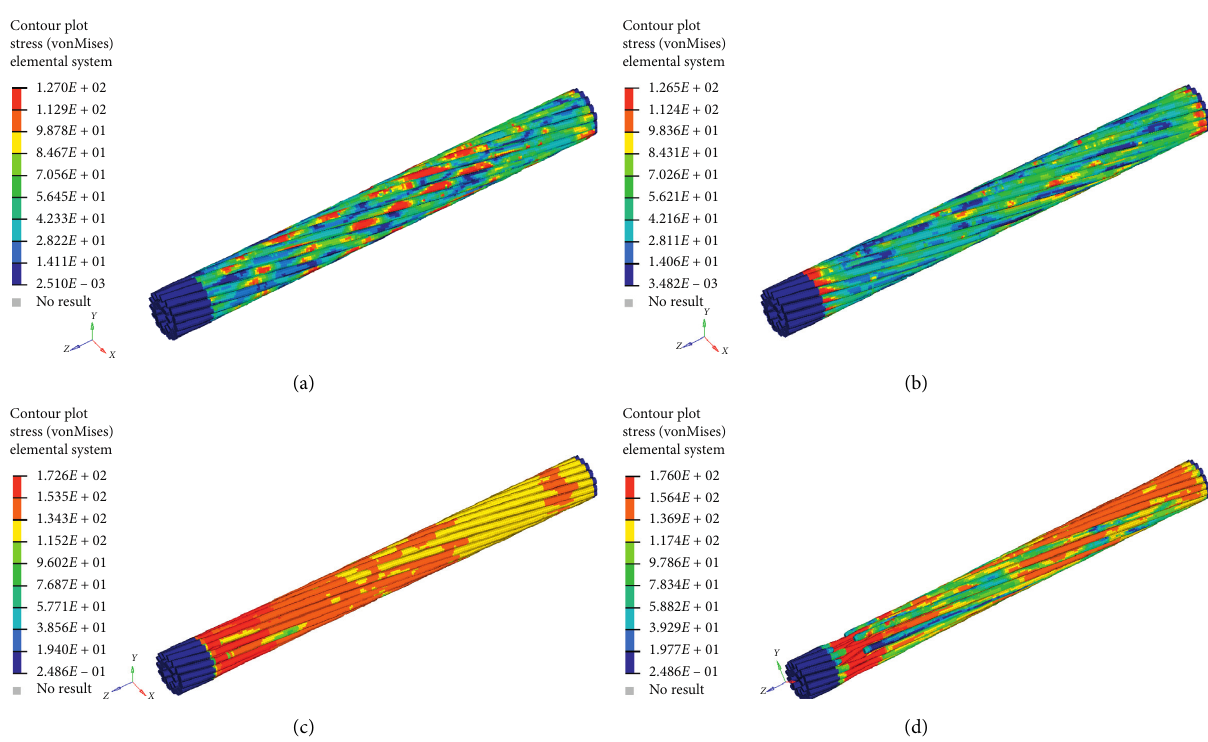
Figure 15: Stress nephograms of aluminum strands in different stretching stages: (a) 25% RTS; (b) 50% RTS; (c) 95% RTS; (d) ultimate